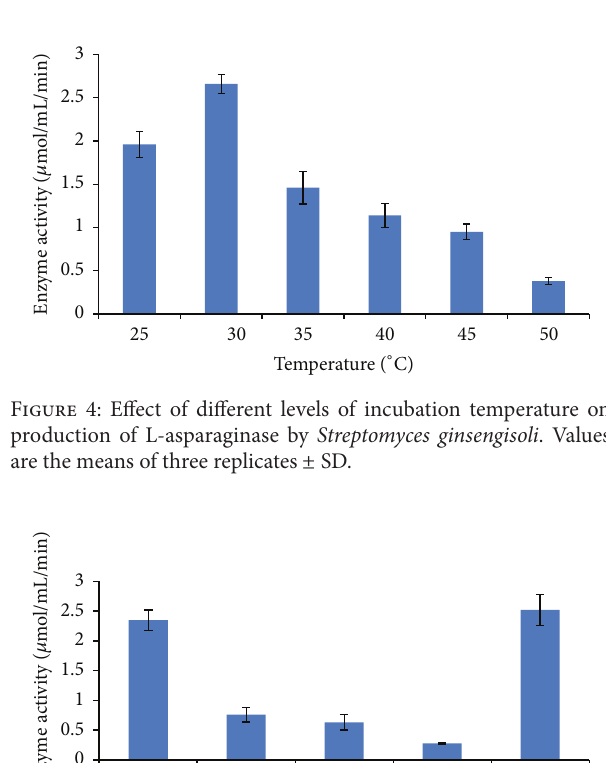
Figure 6: L-asparaginase production by Streptomyces ginsengisoli grown in asparagine dextrose salt broth amended with different nitrogen